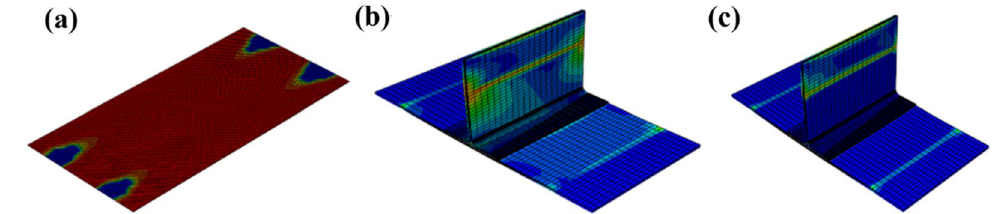
Figure 11. Shearing of T-stiffened panel without prefabrication defects: ( a ) interface failure; ( b ) matrix failure; ( c ) laminate failure (ABAQUS 6.14, https:// www. 3ds. com/ produ cts- servi ces/ simul ia/ produ cts/ abaqus) 43 .